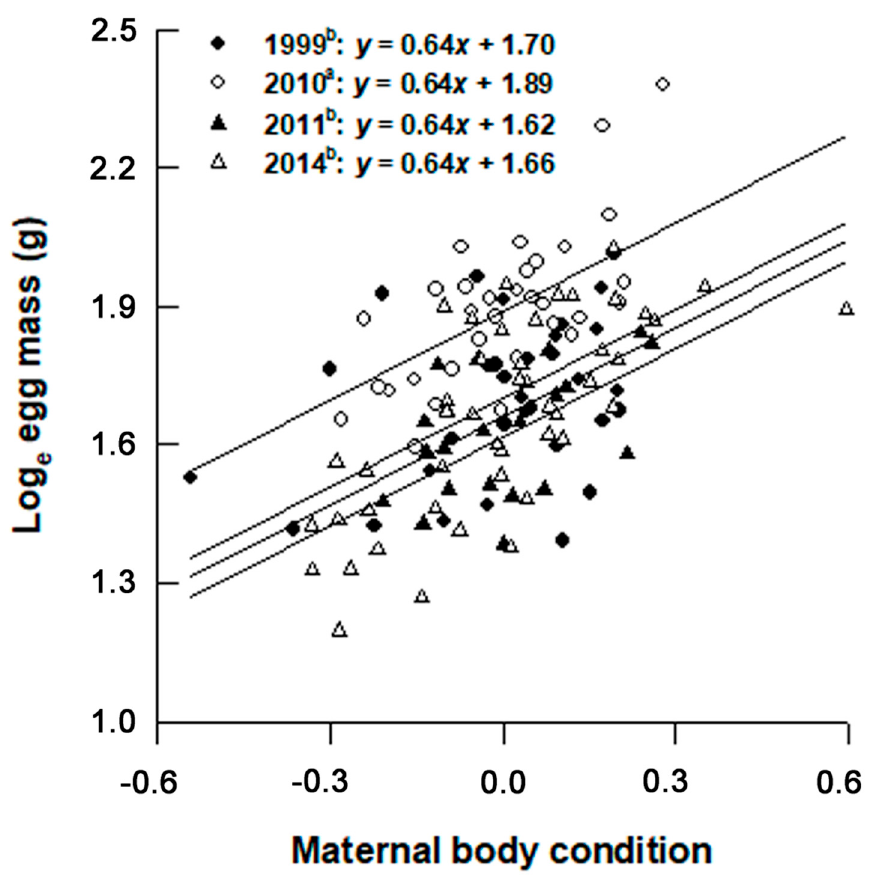
Figure 4. Egg mass in relation to postpartum body condition (calculated as regression residual of postpartum body mass against SVL). All data were log e transformed. Regression lines were adjusted for the four years with a common slope (0.64) to facilitate comparisons. Years with different superscripts differ significantly (Tukey’s post hoc test, α = 0.05, a > b).